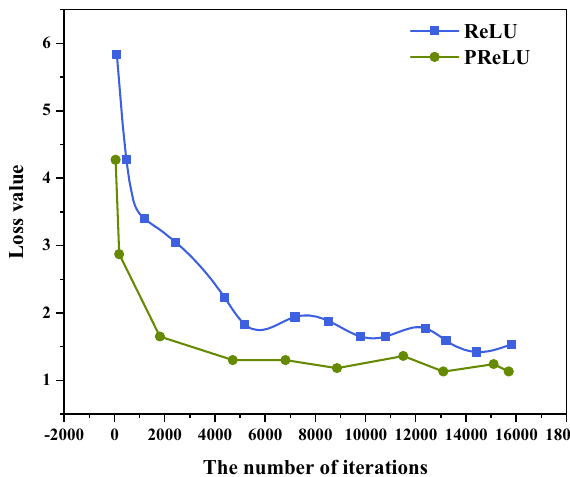
Figure 3: Variation in loss value with iteration times.